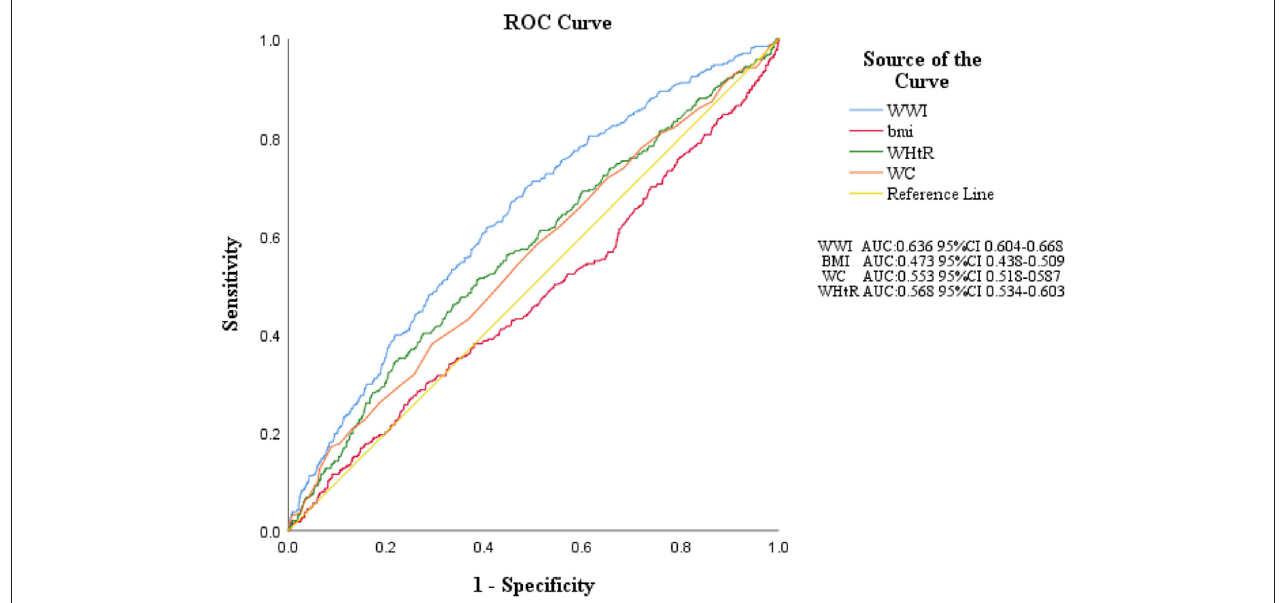
FIGURE 3 | ROC curves of each obesity indices. WWI, weight-adjusted-waist index; BMI, body mass index; WHtR, waist-to-height ratio; WC, waist circumference; ROC, receiver operating characteristic; AUC, area under the